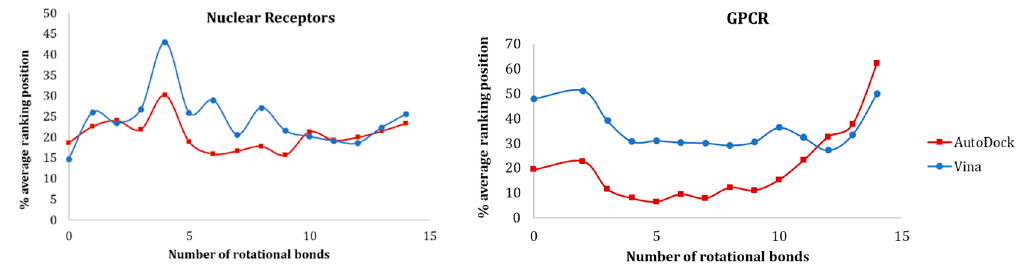
Figure 10. Influence of the number of rotational bonds of the active molecules in the ranking position for nuclear receptors and GPCRs.